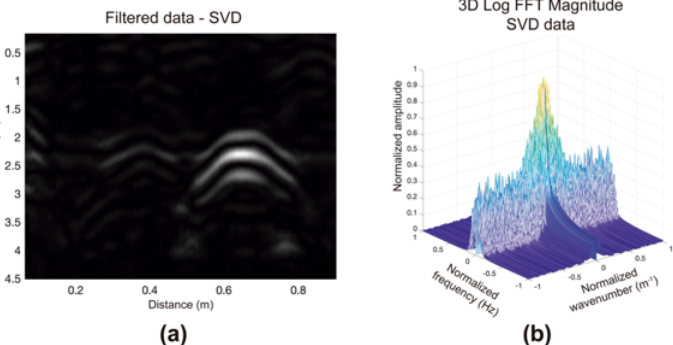
Figure 8. Results of the test to verify the effect of the initial data restoration considering all the principal components except the first one. ( a ) Filtered data. ( b ) 3D magnitudes of the filtered data. By removing the first principal component, which corresponds to the CRN, the restored signal corresponds to the useful information contained in the B-scan.